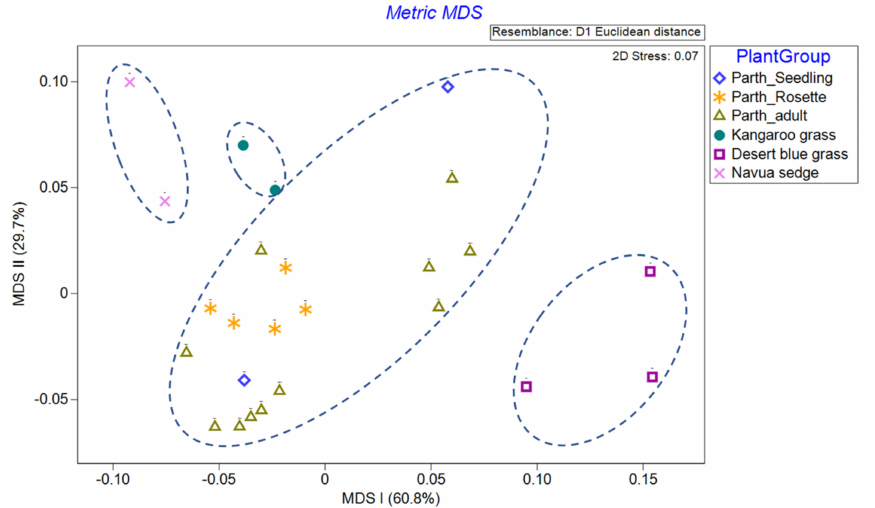
Figure 17. Results of ordination performed on the spectral signatures of each plant, showing separate groupings of each plant species (circled). Within the parthenium grouping, plants in the rosette stage are highly aggregated (asterisks), while those of flowering plants appeared in two subgroups (open